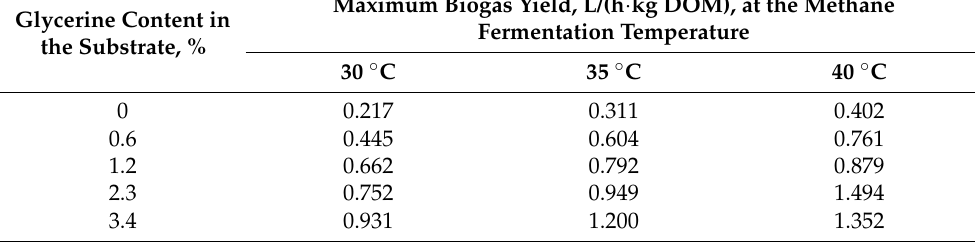
Table 1. Maximum biogas yield of cattle manure fermentation with the addition of crude glycerine for the periodic loading system (L/(h ⋅ kg DOM)). Glycerine Content in the Substrate, %